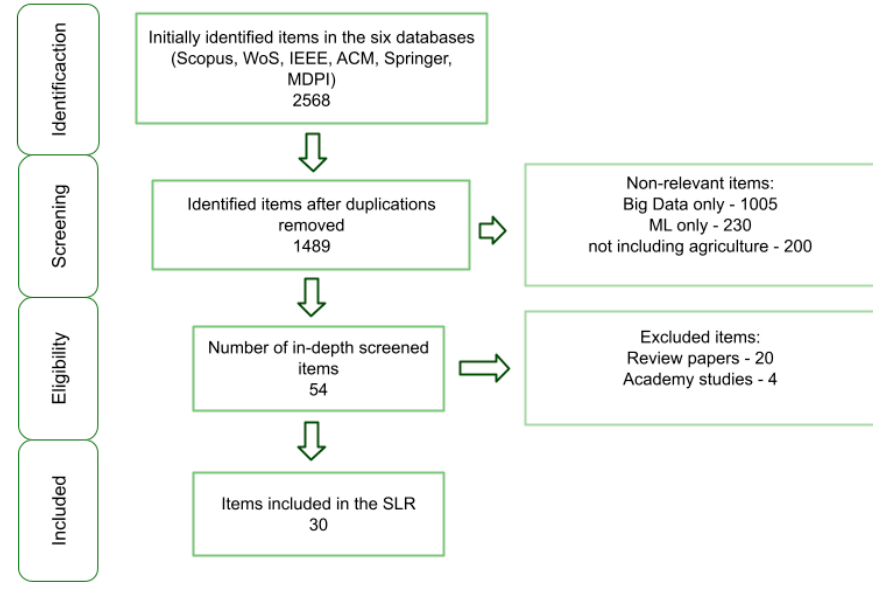
Figure 7. Flowchart of the literature selection process.